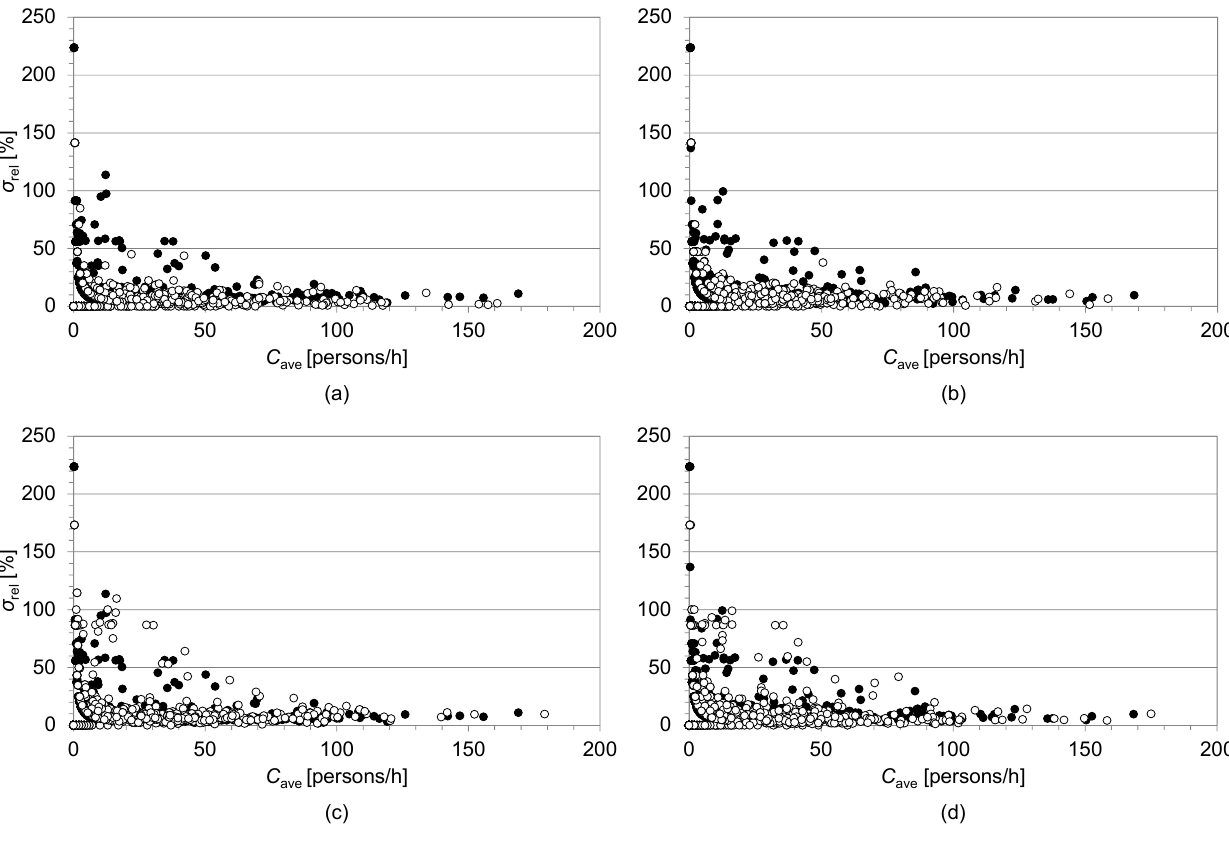
) of the sensor readings as a function of the Figure 5. Relative standard deviation ( σ rel ) for the light beam sensors ( a ) to A direction and ( b ) to B direction, average reading ( C ave and for the camera sensors ( c ) to A direction and ( d ) to B direction (marked with ○ ). Each plot compares the deviation of the specific sensor group to the overall deviation of all direction sensitive sensors (marked with ●